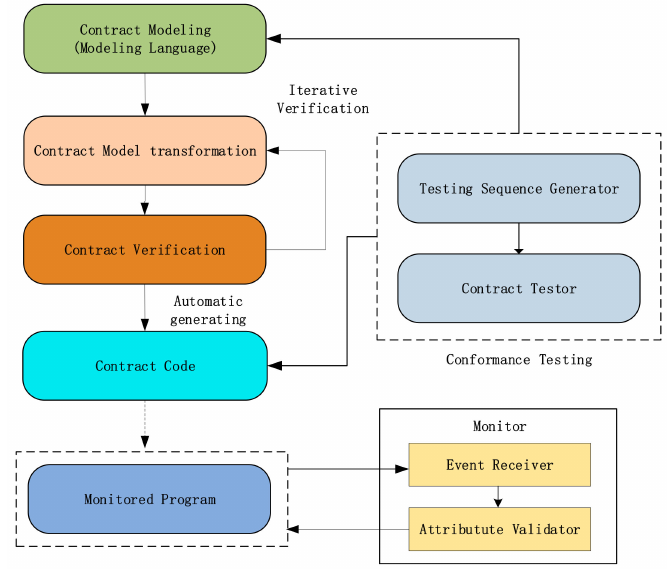
Figure 3. The process of smart contracts